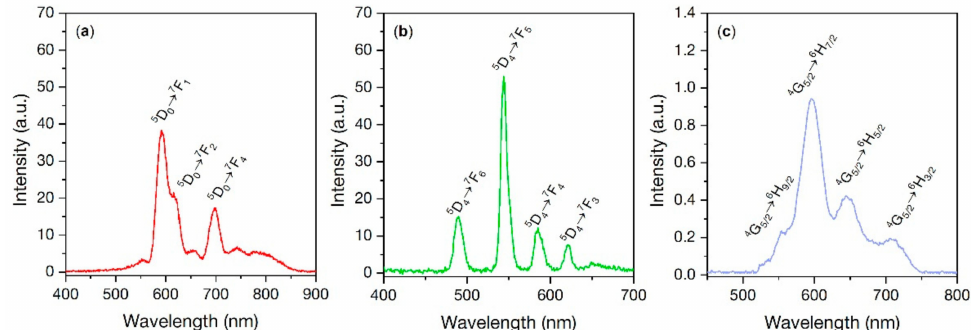
Figure 6. XEOL spectra measured for ( a ) BaGdF 5 :Eu, ( b ) BaGdF 5 :Tb, ( c ) BaGdF 5 :Sm. The numbered peaks correspond to 5 D 0 → 7 F 1 , 5 D 0 → 7 F 2 , 5 D 0 → 7 F 4 transitions for BaGdF 5 :Eu; 5 D 4 → 7 F 6 , 5 D 5 D 5 D → 7 F → 7 F → 7 F 4 5 , 4 4 , 4 3 transitions for BaGdF 5 :Tb; and 4 G 4 G → 6 H → 6 H 5/2 5/2 , 5/2 3/2 transitions for BaGdF 5 :Sm, respectively.